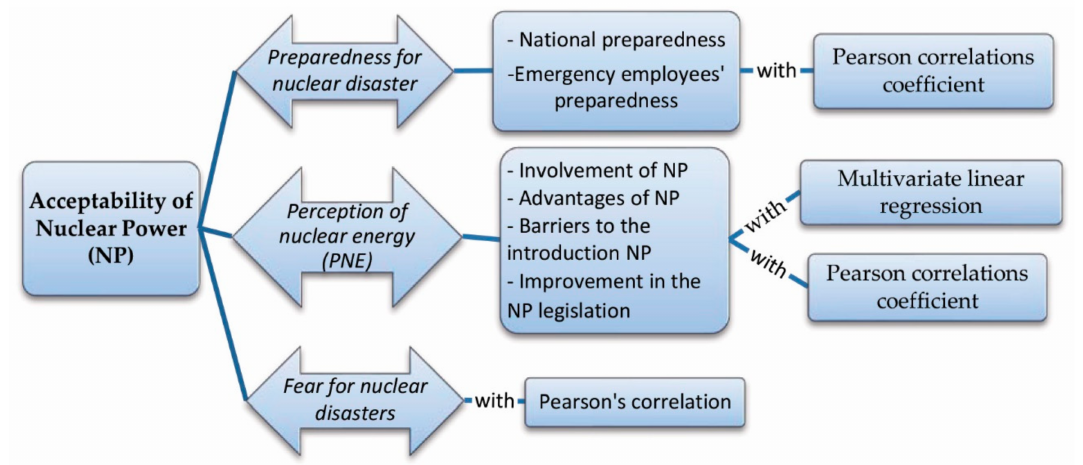
Figure 1. Model of acceptability of nuclear power (nuclear